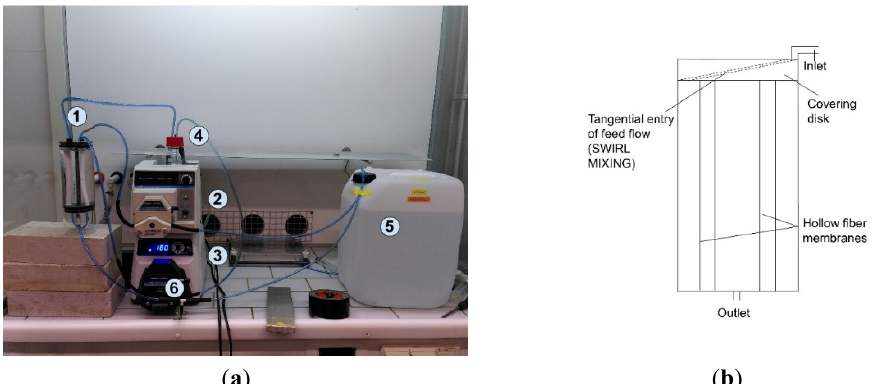
Figure 1. ( a ) Experimental set-up: (1) membrane reactor, (2) peristaltic pump for feed-stream side, (3) Masterflex peristaltic pump for acid side, (4) 80 mL acid container and sampling point for acid side, (5) 20 L tank for feed stream, and (6) T-valve used as sampling point for feed-stream side. ( b ) Schematic representation of the induced mixing mechanism.